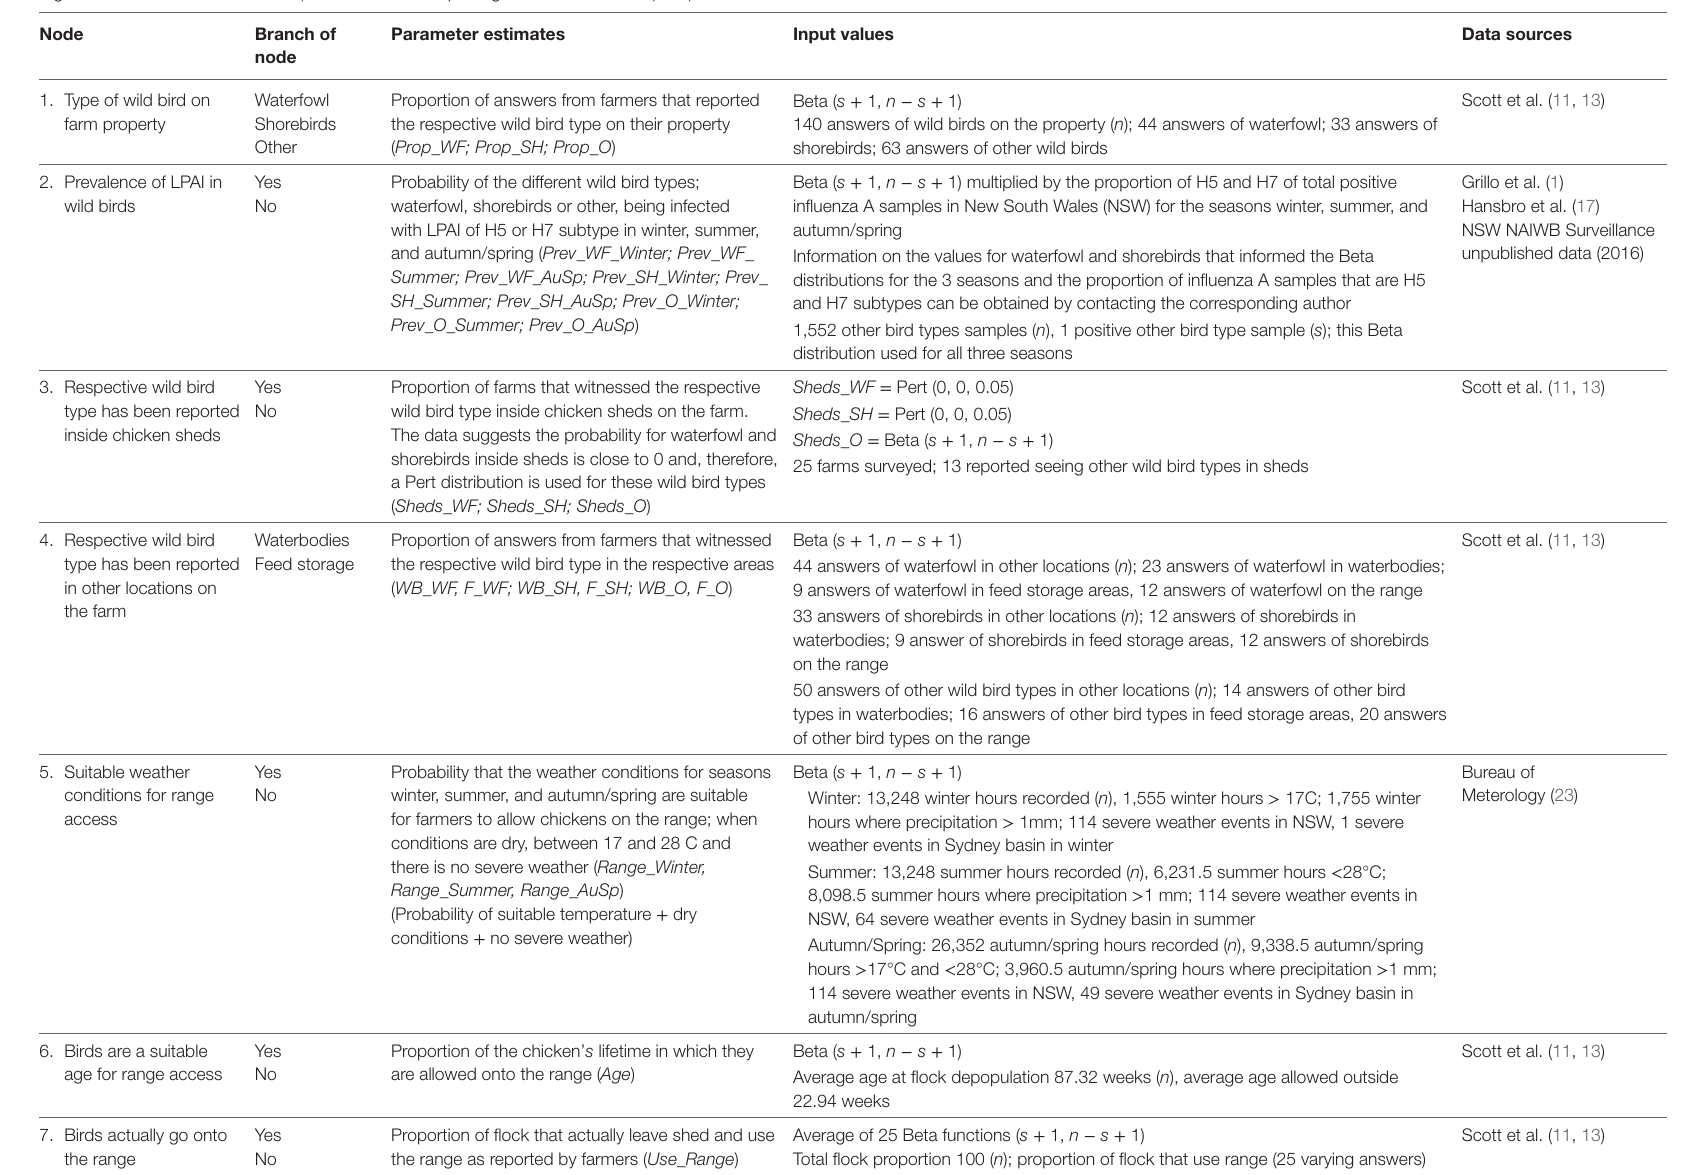
TaBle 5 | Nodes, parameter estimates and input values used for the exposure assessment estimating the probability of exposure of commercial chickens on free-range layer farms (specifically in the Sydney basin region and South East Queensland) in Australia to low pathogenic avian influenza (LPAI) from wild